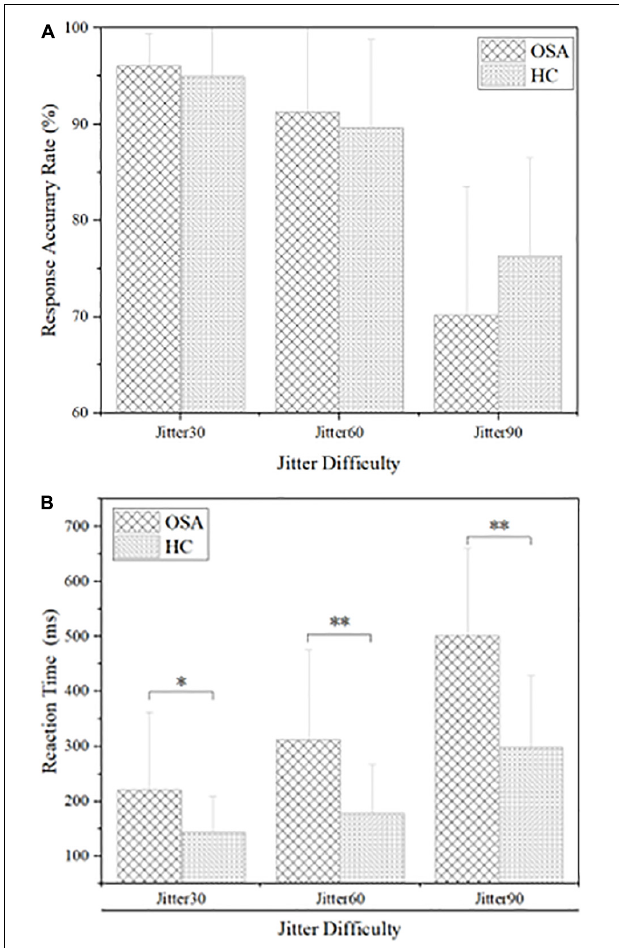
FIGURE 3 | Comparison of behavioral results between obstructive sleep apnea (OSA) group and healthy control (HC) group, (A) accuracy rate under each condition; (B) reaction time under each condition. * p < 0.05, ** p < 0.01.